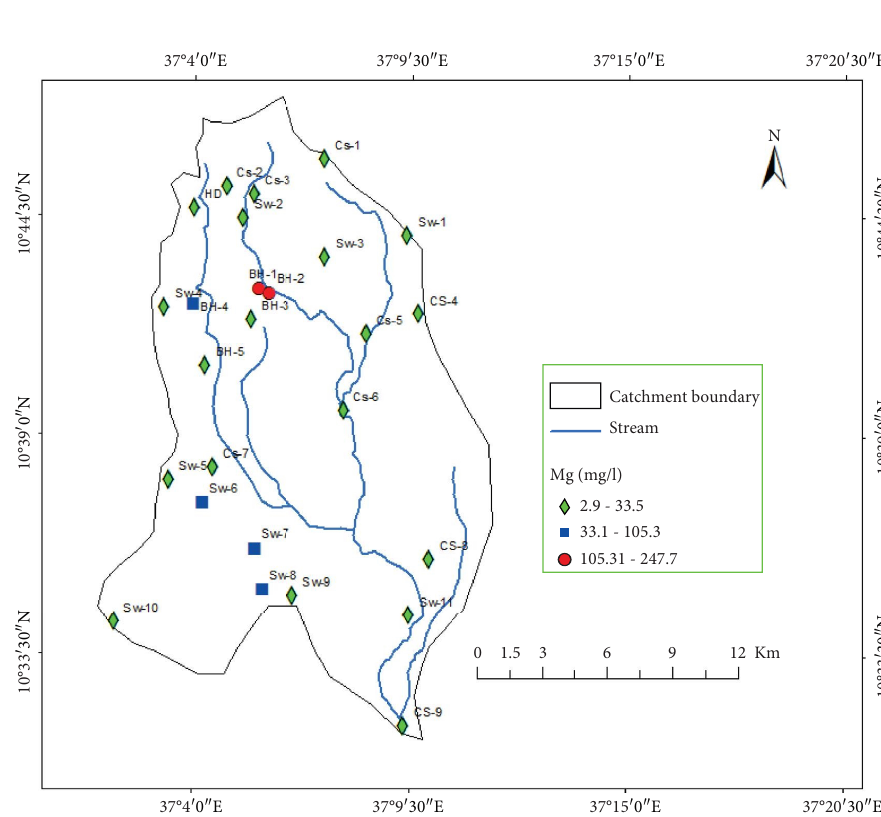
Figure 12: Spatial variability map of